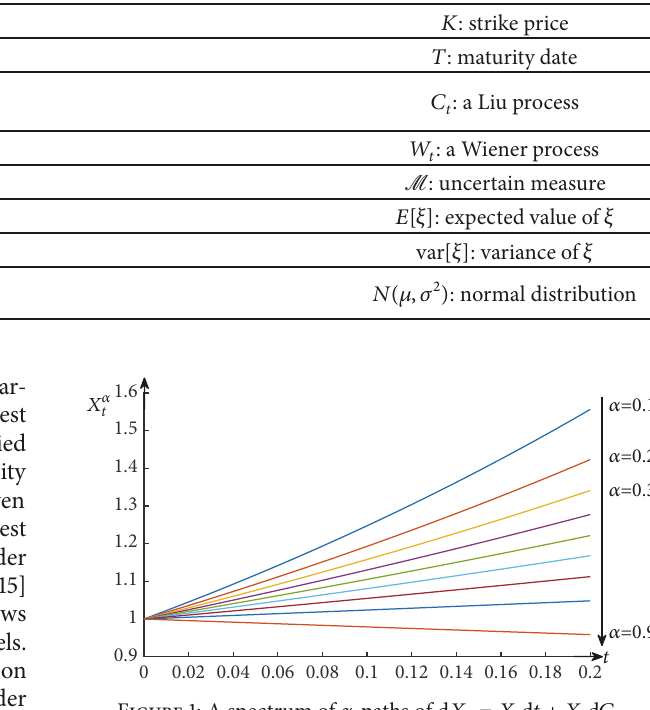
Figure 1: A spectrum of 𝛼 -paths of d 𝑋 𝑡 = 𝑋 𝑡 d 𝑡 + 𝑋 𝑡 d 𝐶 𝑡